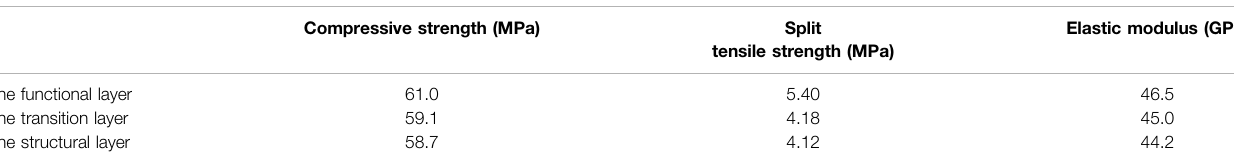
TABLE 1 | The mechanical properties of the